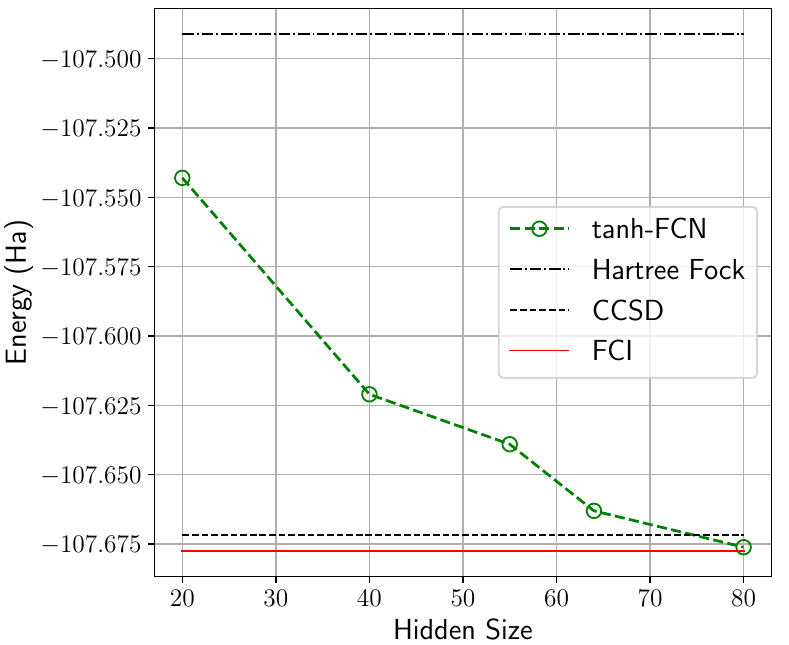
Figure 2. Influence of the number of hidden spins in our tanh-FCN on the accuracy of the final energy. The N2 molecule in the STO-3G basis is used.